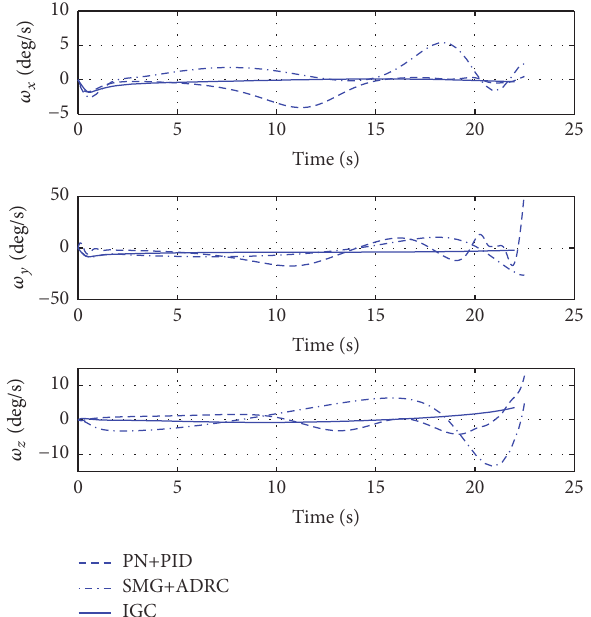
Figure 9: The range of rotational angular velocity with respect to time in Scenario